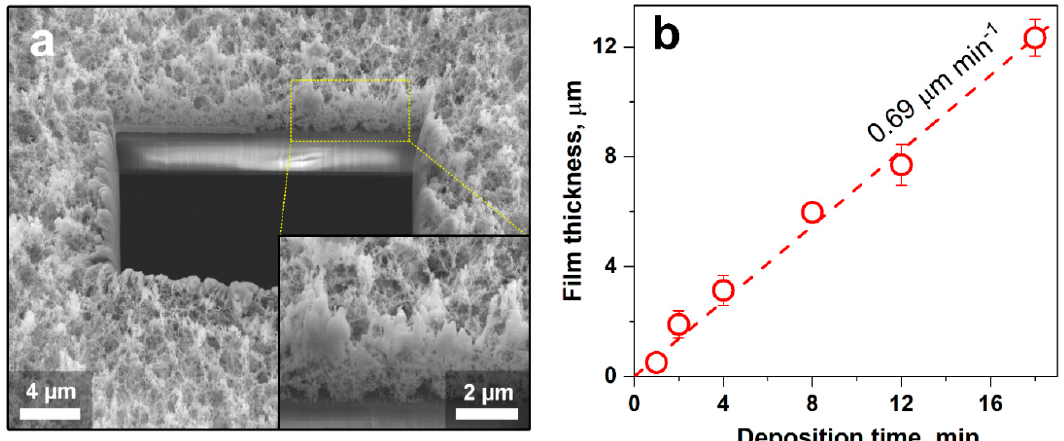
Figure 2. Film characterization. Cross-sectional SEM images of ( a ) porous 4-min flame-deposited film (on microsensor substrates) after cutting a square with a focused ion beam. Higher magnification is provided as inset. ( b ) The thickness of the deposited films as a function of deposition time. Symbols indicate average thicknesses, and error bars (some hidden behind the symbols) the standard deviations of, at least, 40 measured thicknesses per film. Dashed line represents a linear fit with indicated deposition rate.